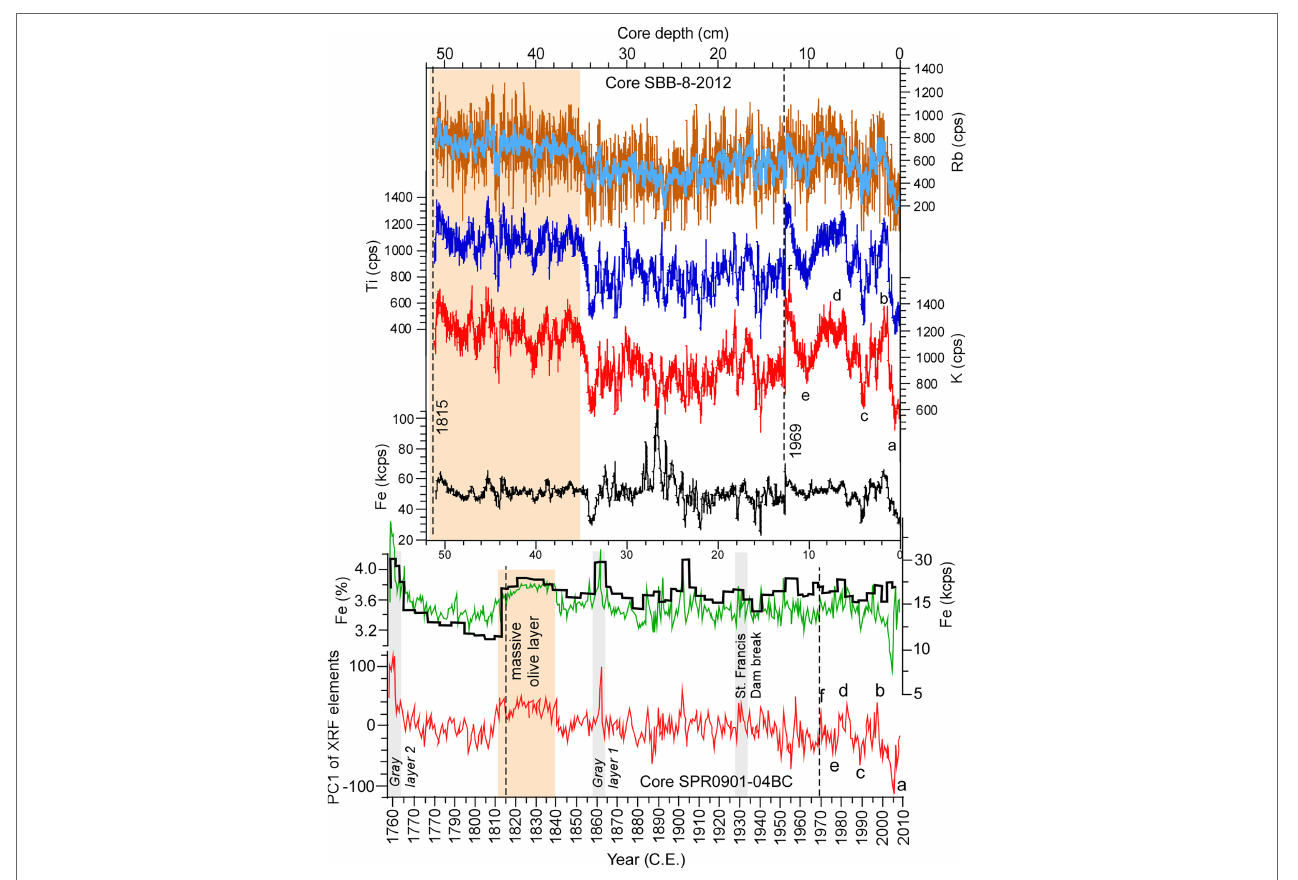
FIGURE 3 | Comparison of scanned XRF elemental contents between Core SBB-8-2012 (this study) and Core SPR0901-04BC (Hendy et al., 2015) from the Santa Barbara Basin. Curves for Fe, K and Ti are 9-point running average of the raw data (roughly monthly resolution). For Rb, the orange curve represents the raw data, and the light blue curve stands for 9-point running average of the raw